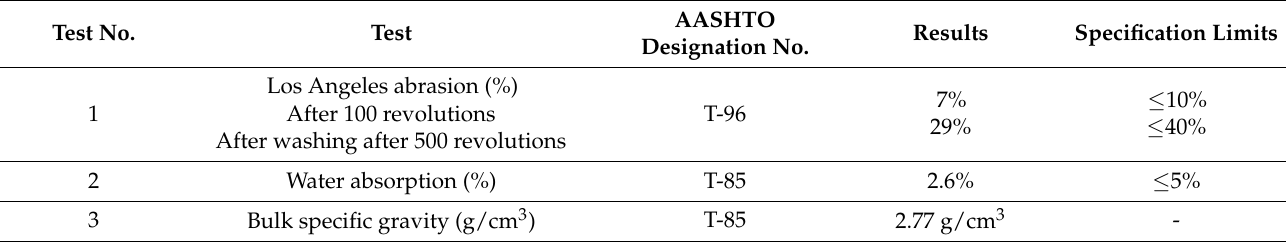
Table 7. Aggregates characteristics of subbase